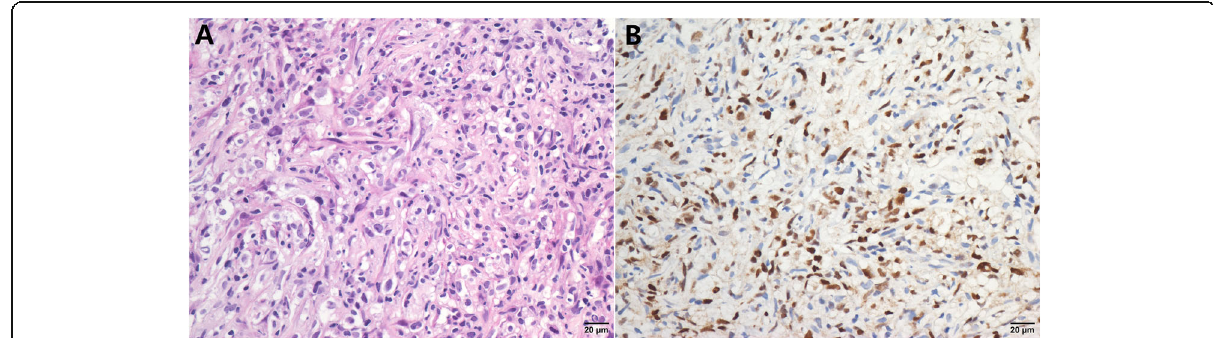
Fig. 3 P63 expression in primary mediastinal large B-cell lymphoma. a HE staining of a typical case of primary mediastinal large B-cell lymphoma. b P63 was highly expressed in this case, with 9 scores (3 for proportion * 3 for staining intensity)